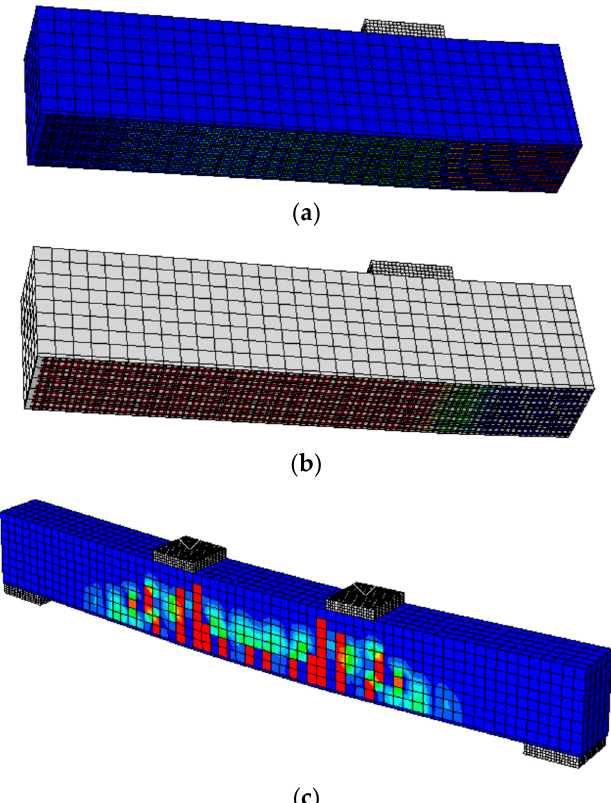
Figure 5. Typical failure mechanisms of beams with different CF/cementitious matrix bond interface strength ( a ) stress state in carbon fibre mesh just before the slippage occurs (MPa), ( b ) the slippage of the CF mesh (mm), ( c ) the flexural cracks in the concrete beam.